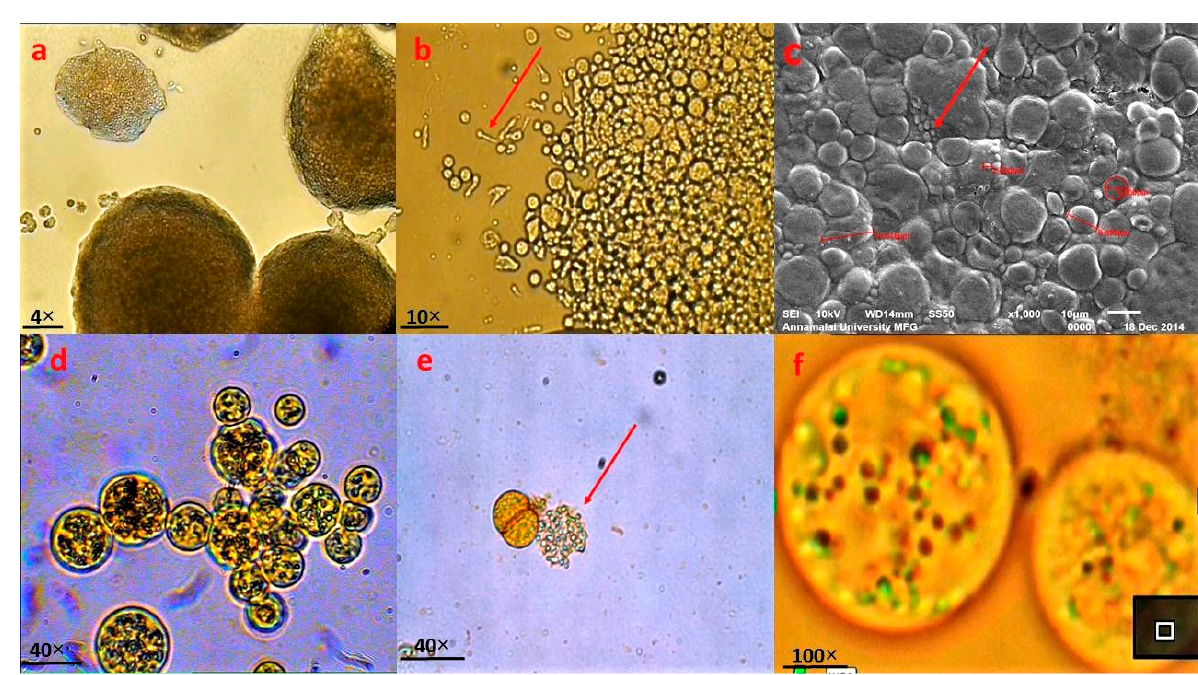
Figure 1. Light and scanning electron microscopic (SEM) analysis of thraustochytrid strain TSKK1 ( Thraustochytrium kinnei ). ( a ) Clusters of vegetative cells dividing through binary cell division. ( b ) Clusters of smaller mature vegetative cells and many active zoospores and larger amoeboid cells. ( c ) Mature vegetative cells, active zoospores and larger amoeboid cells. ( d ) Mature zoosporangium with active zoospores as it is about to explode. ( e ) Vegetative cells and sporangiophores (just exploded in zoosporangium). ( f ) Many intercellular organelles, such as Golgi bodies, vacuoles, lipids, and nucleus.